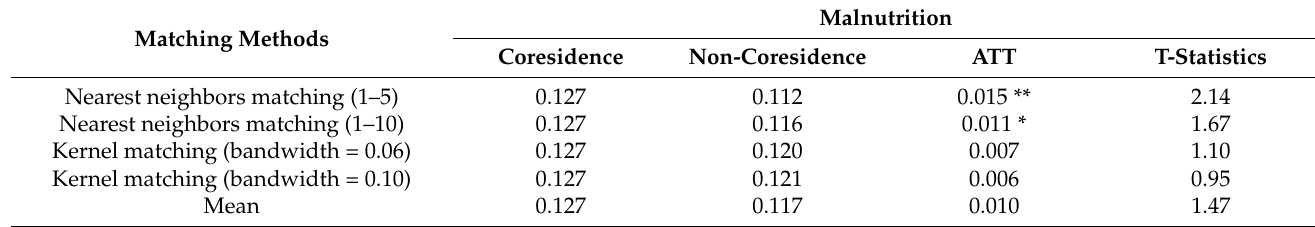
Table 5. Effect of grandparents’ coresidence on children’s and adolescents’ malnutrition.